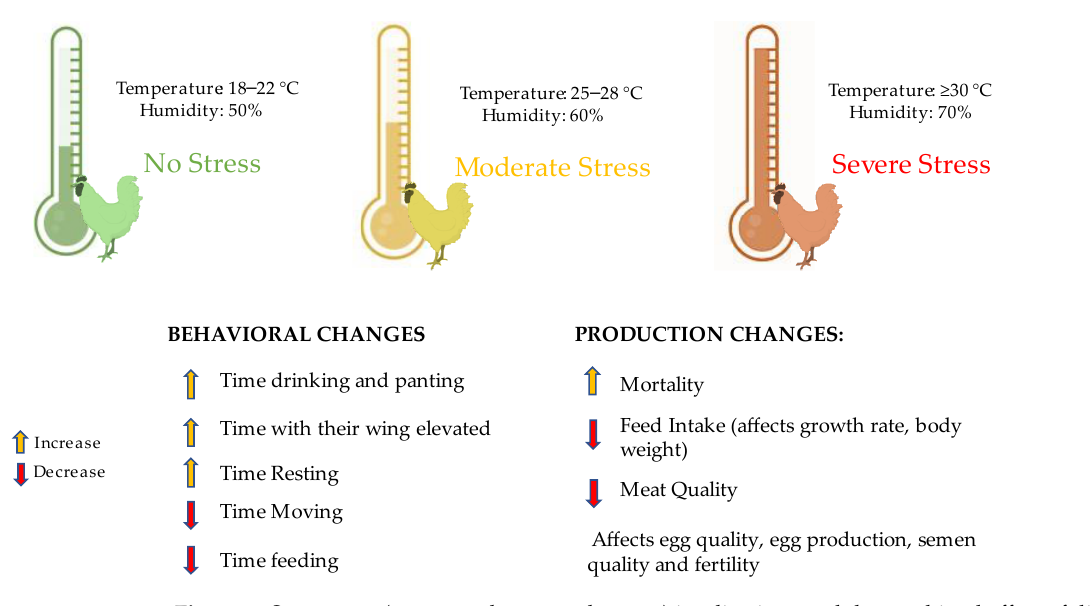
Figure 3. Stress type (none, moderate, and severe) implications and the combined effect of different temperatures and humidity on birds and their implications on performance and behavior.